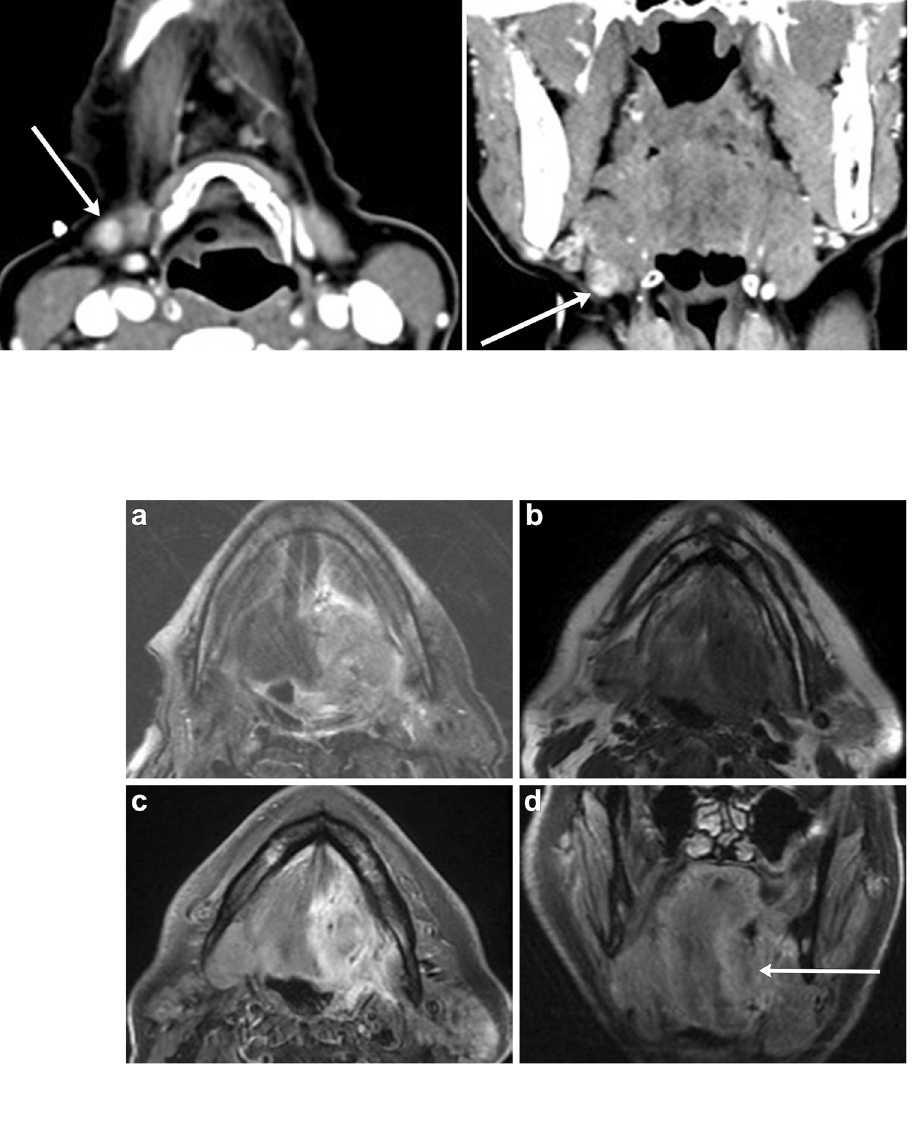
Fig. 15 Squamous cell carcinoma involving the left sublingual space. a Axial contrast-enhanced CTimage shows a homogenously enhancing lesion within the left sublingualspace( arrow ), b which demonstrates 18 F- fluorodeoxyglucose (FDG) avidity on PET/CT